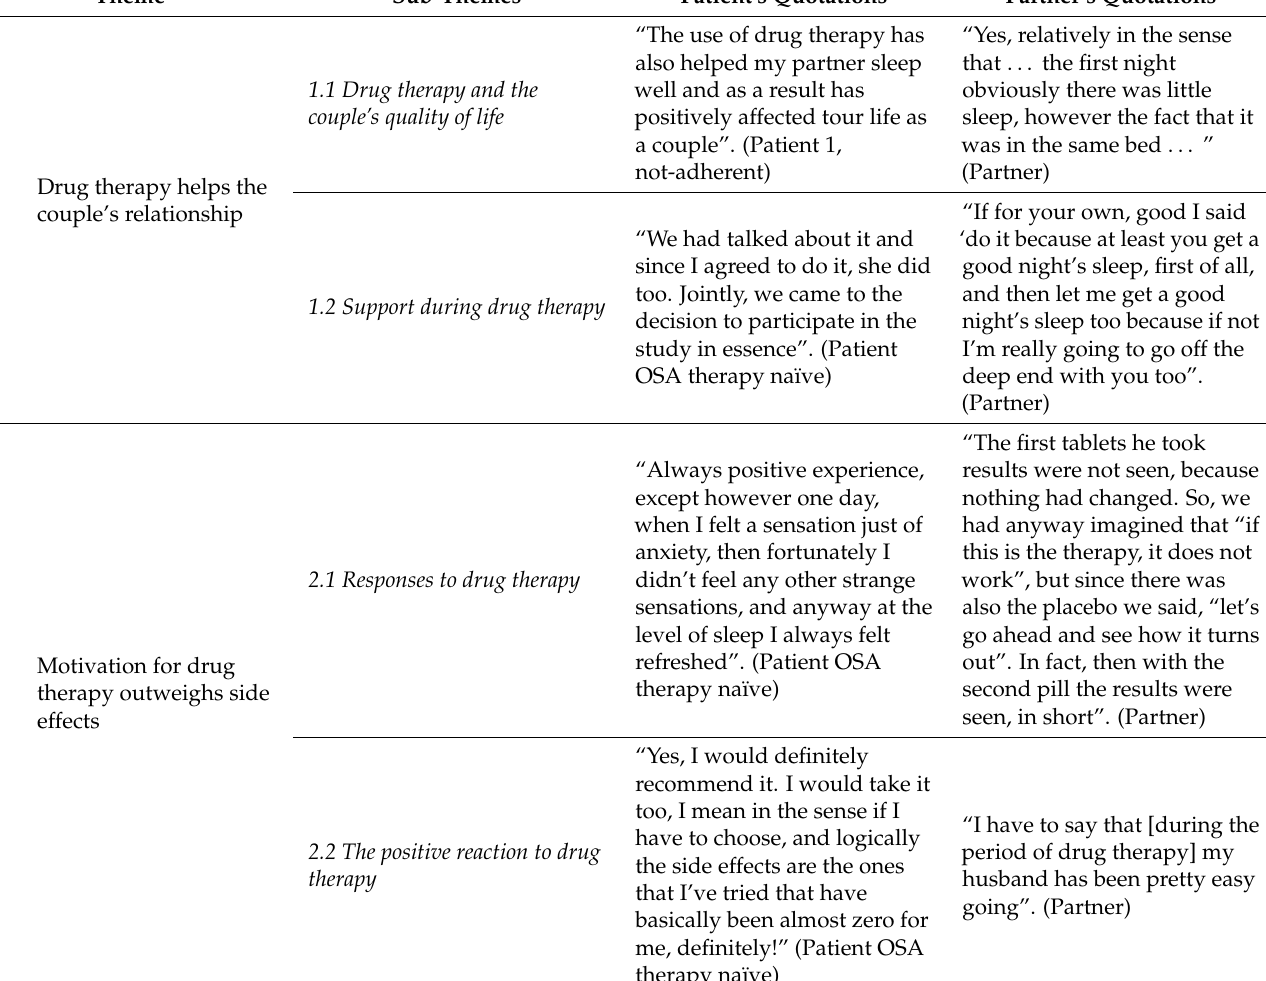
Table 3. Themes, subthemes, and